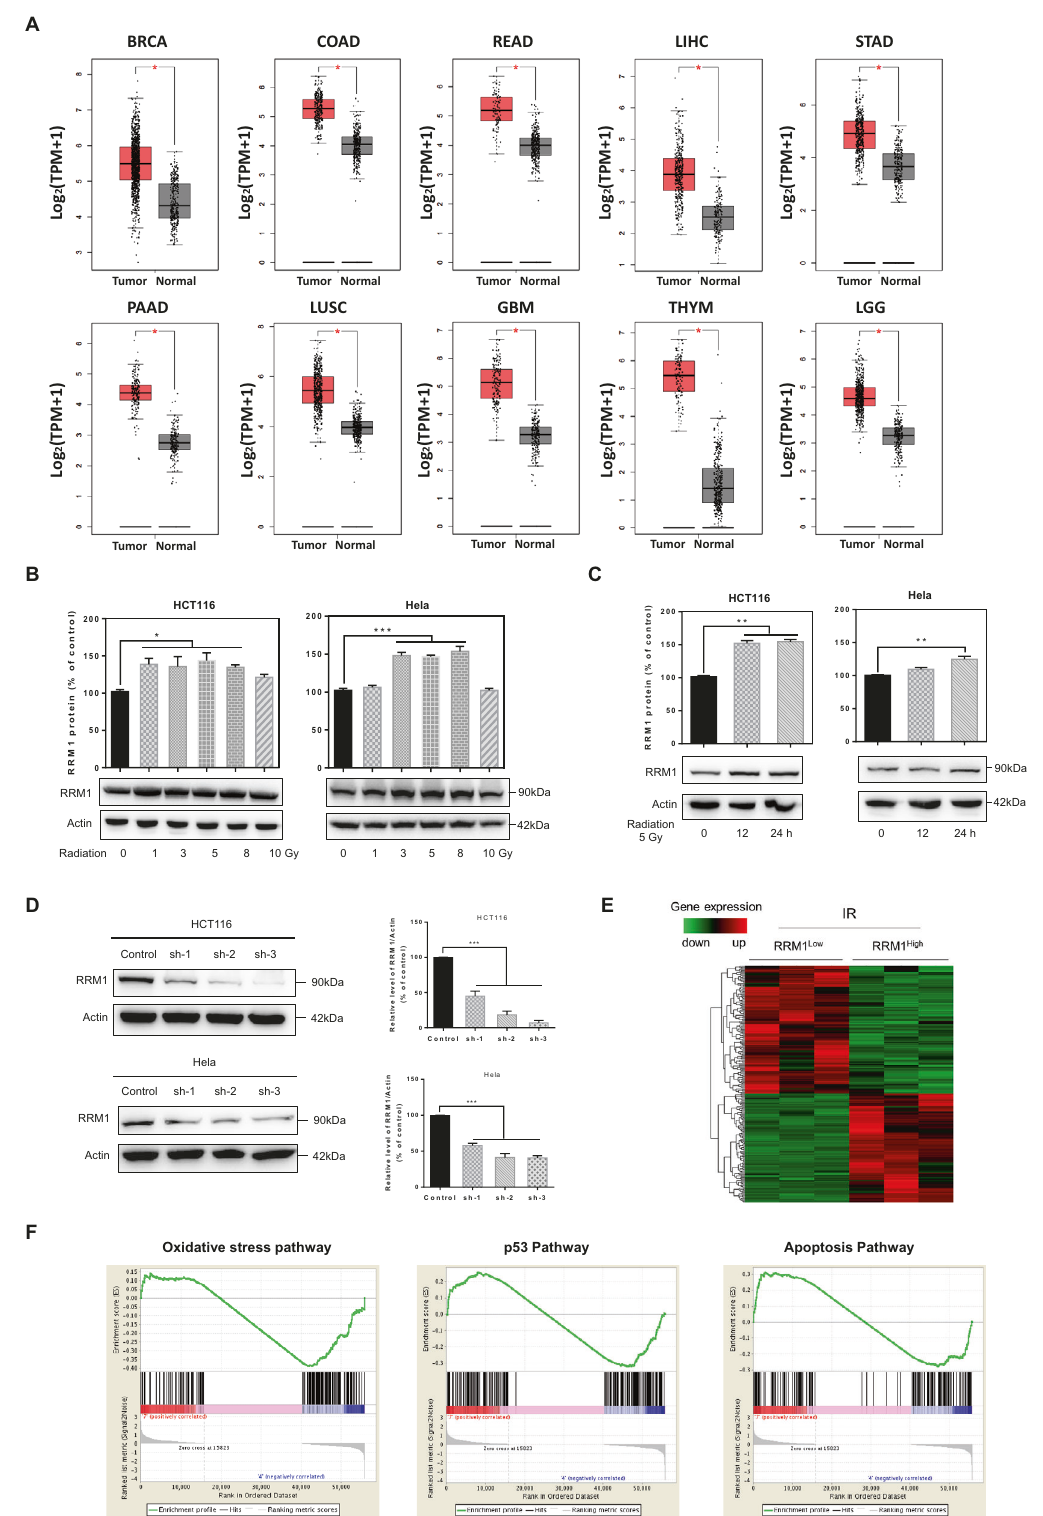
Fig. 1 RRM1 is highly expressed after radiation. A TCGA data show that RRM1 is overexpressed in multiple cancer types. B , C Cells were irradiated with γ -ray at different doses ( B ) or 5 Gy ( C ), and the protein levels of RRM1 were detected after 24 h ( B ) or at different time points ( C ). D RRM1 expression was stably reduced by lentiviral infection. E Heatmap from the 224 differentially expressed genes comparing two groups: RRM1 Low to RRM1 High . F Gene Set Enrichment Assay (GSEA) compares two phenotypes, RRM1 Low and RRM1 High